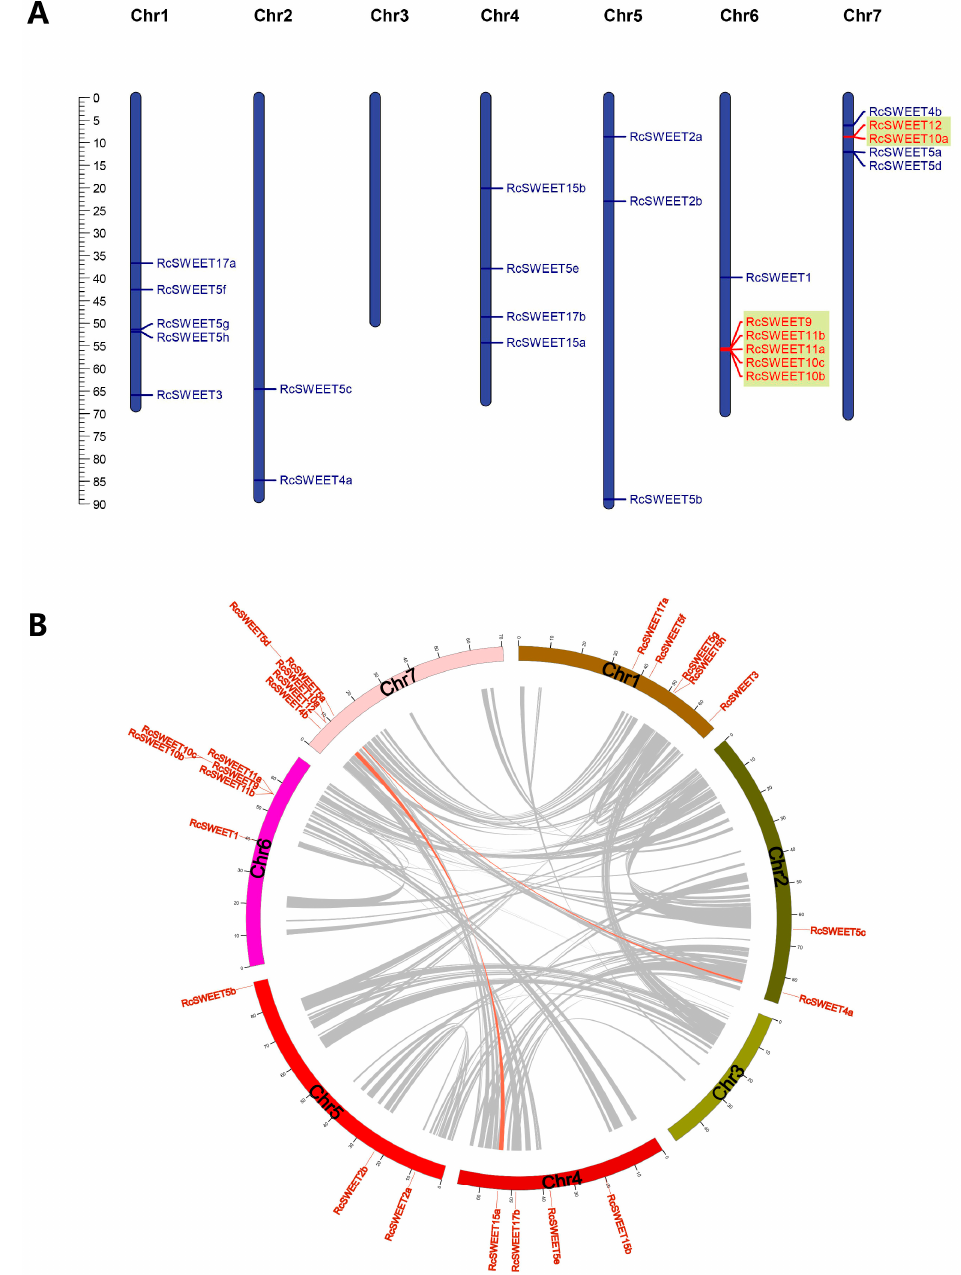
Figure 3. Chromosomal location and gene duplication of the RcSWEET genes. ( A ) Tandem duplication of RcSWEET genes. The tandemly duplicated genes are marked by laurel-green rectangles. ( B ) Segmental duplication of the RcSWEET genes. The segmentally duplicated genes of the R. chinensis genome are connected by gray lines, and the segmentally duplicated genes of the RcSWEET family are highlighted.